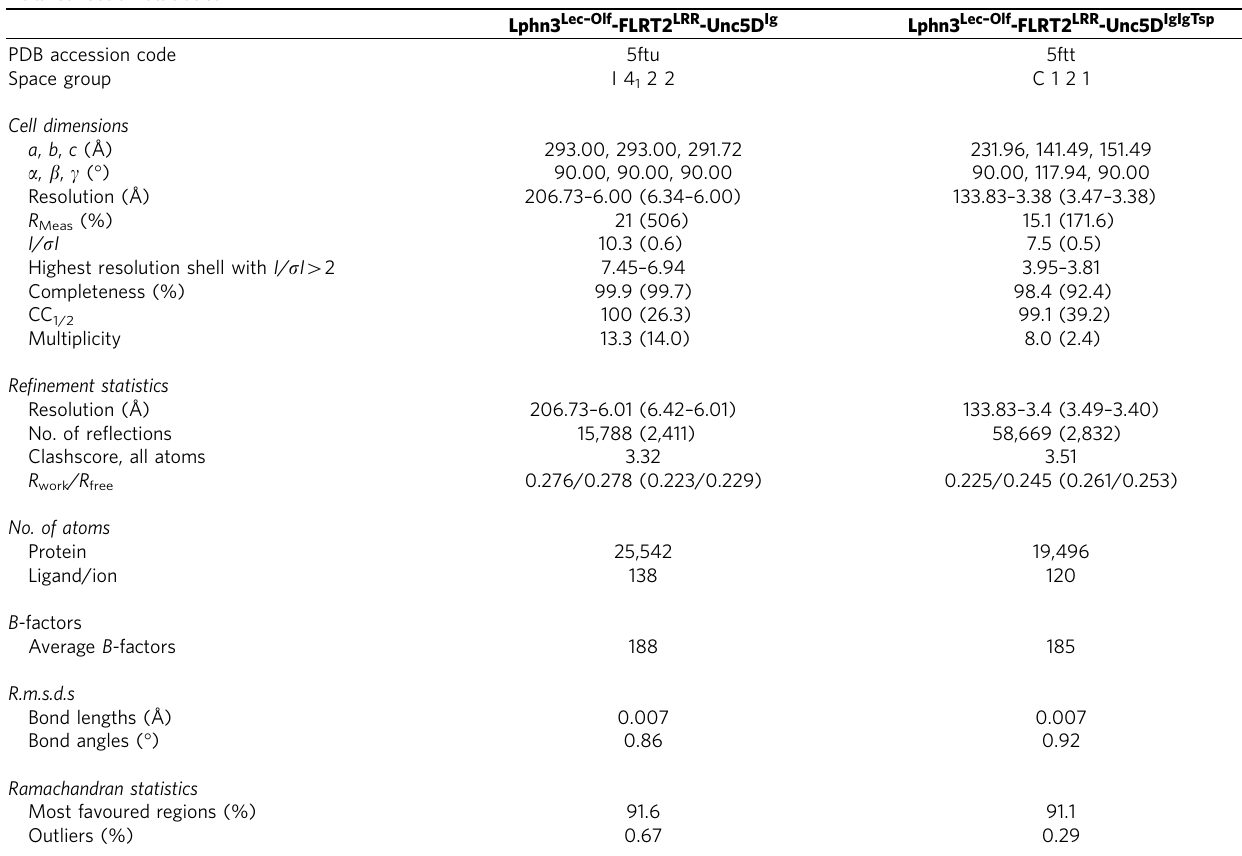
Table 1 | Crystallographic